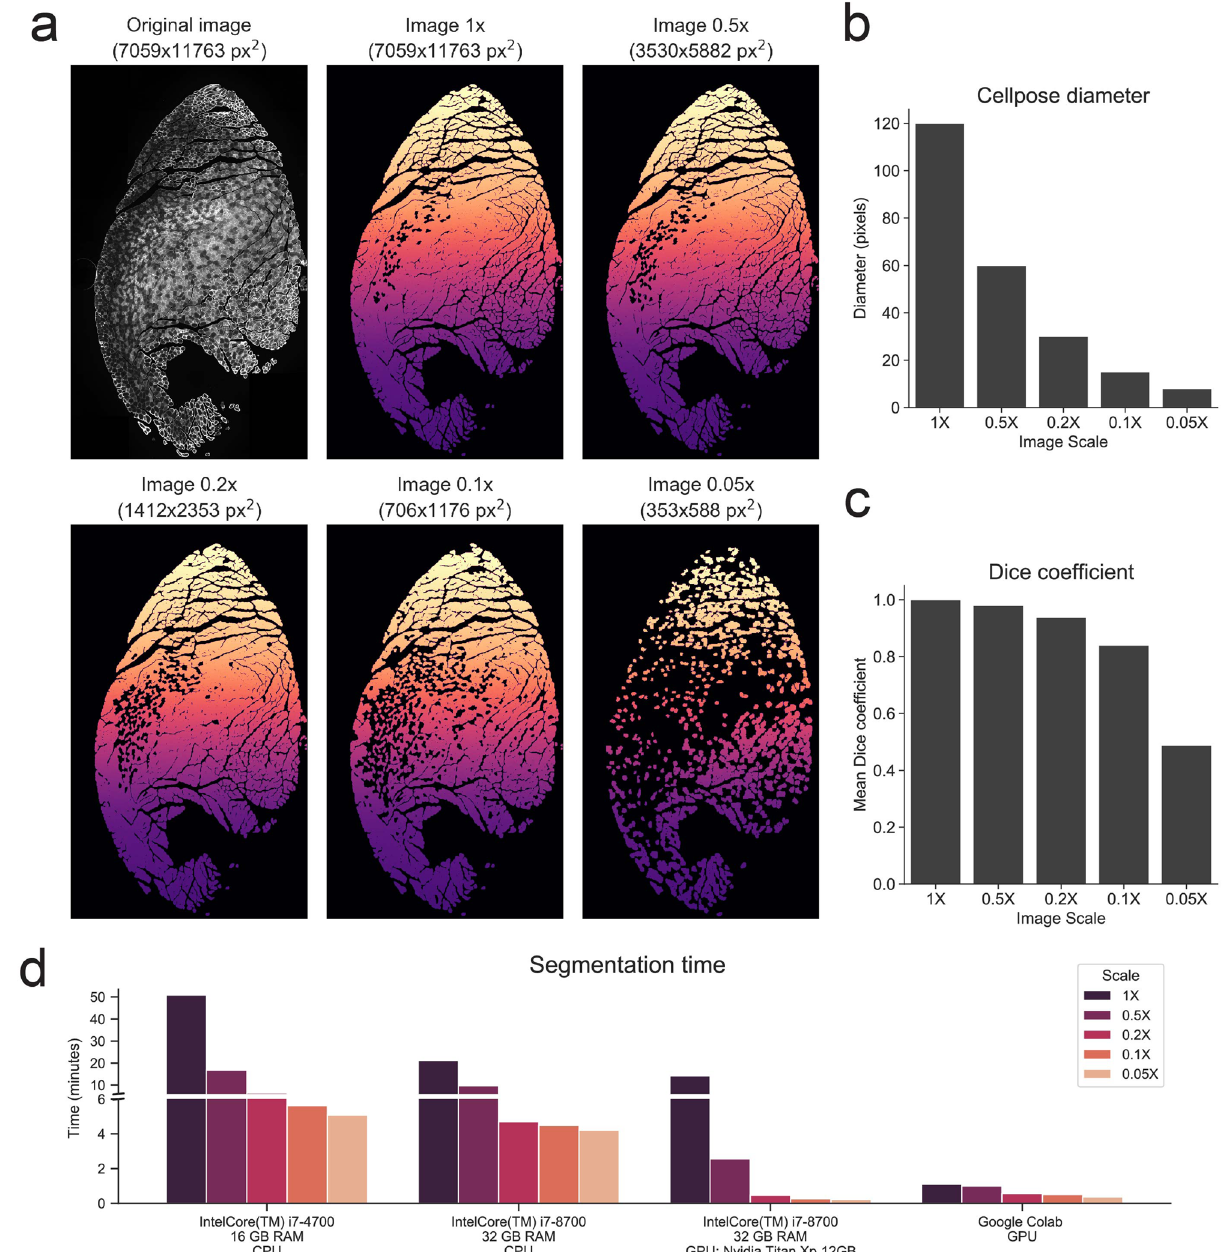
Figure 4. Benchmarking of Cellpose algorithm across different image sizes and hardware specifications. ( a ) Top-left, original full-sized PFA-fixed TA cross-section stained for Laminin. The remaining images correspond to the Cellpose-generated label images when full-sized or downscaled versions of the original image were fed to the algorithm. ( b ) Myofiber diameter fed to the Cellpose algorithm for the full-sized or the downscaled images. Approximate myofiber diameter for the original image was manually determined. ( c ) Mean Dice coefficient for the comparison of the original 1 × label image with itself or with the downscaled label images (see “Methods”). ( d ) Comparison of Cellpose segmentation time for the different image sized across different hardware